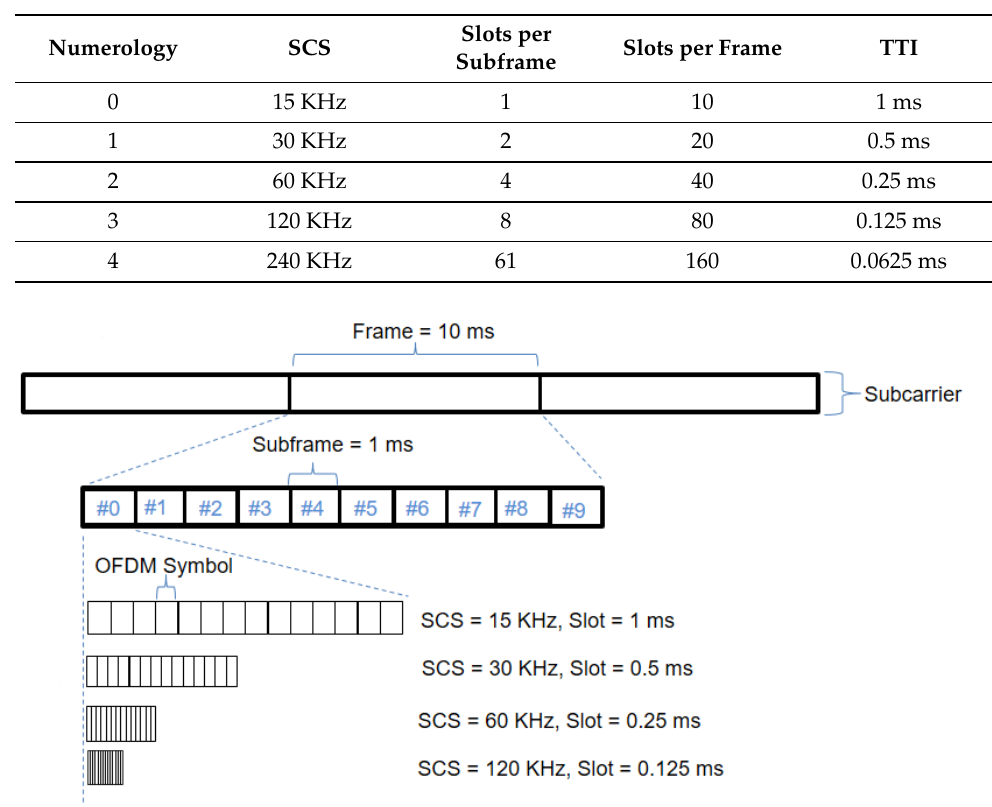
Table 2. Supported numerologies in NR-V2X.